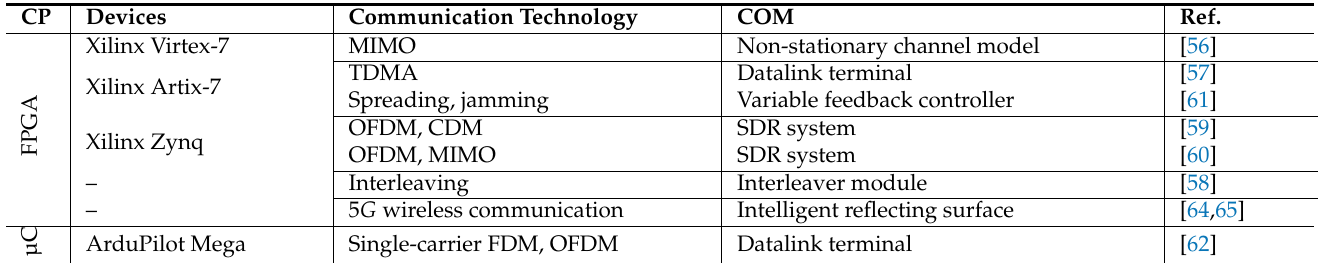
Table 5. Computing platforms used in UAV communication